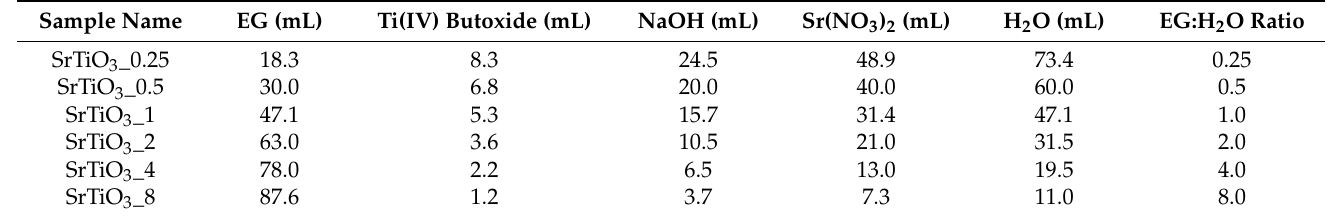
Table 2. Volumes of reactants and EG:H 2 O ratios applied during the synthesis of SrTiO 3